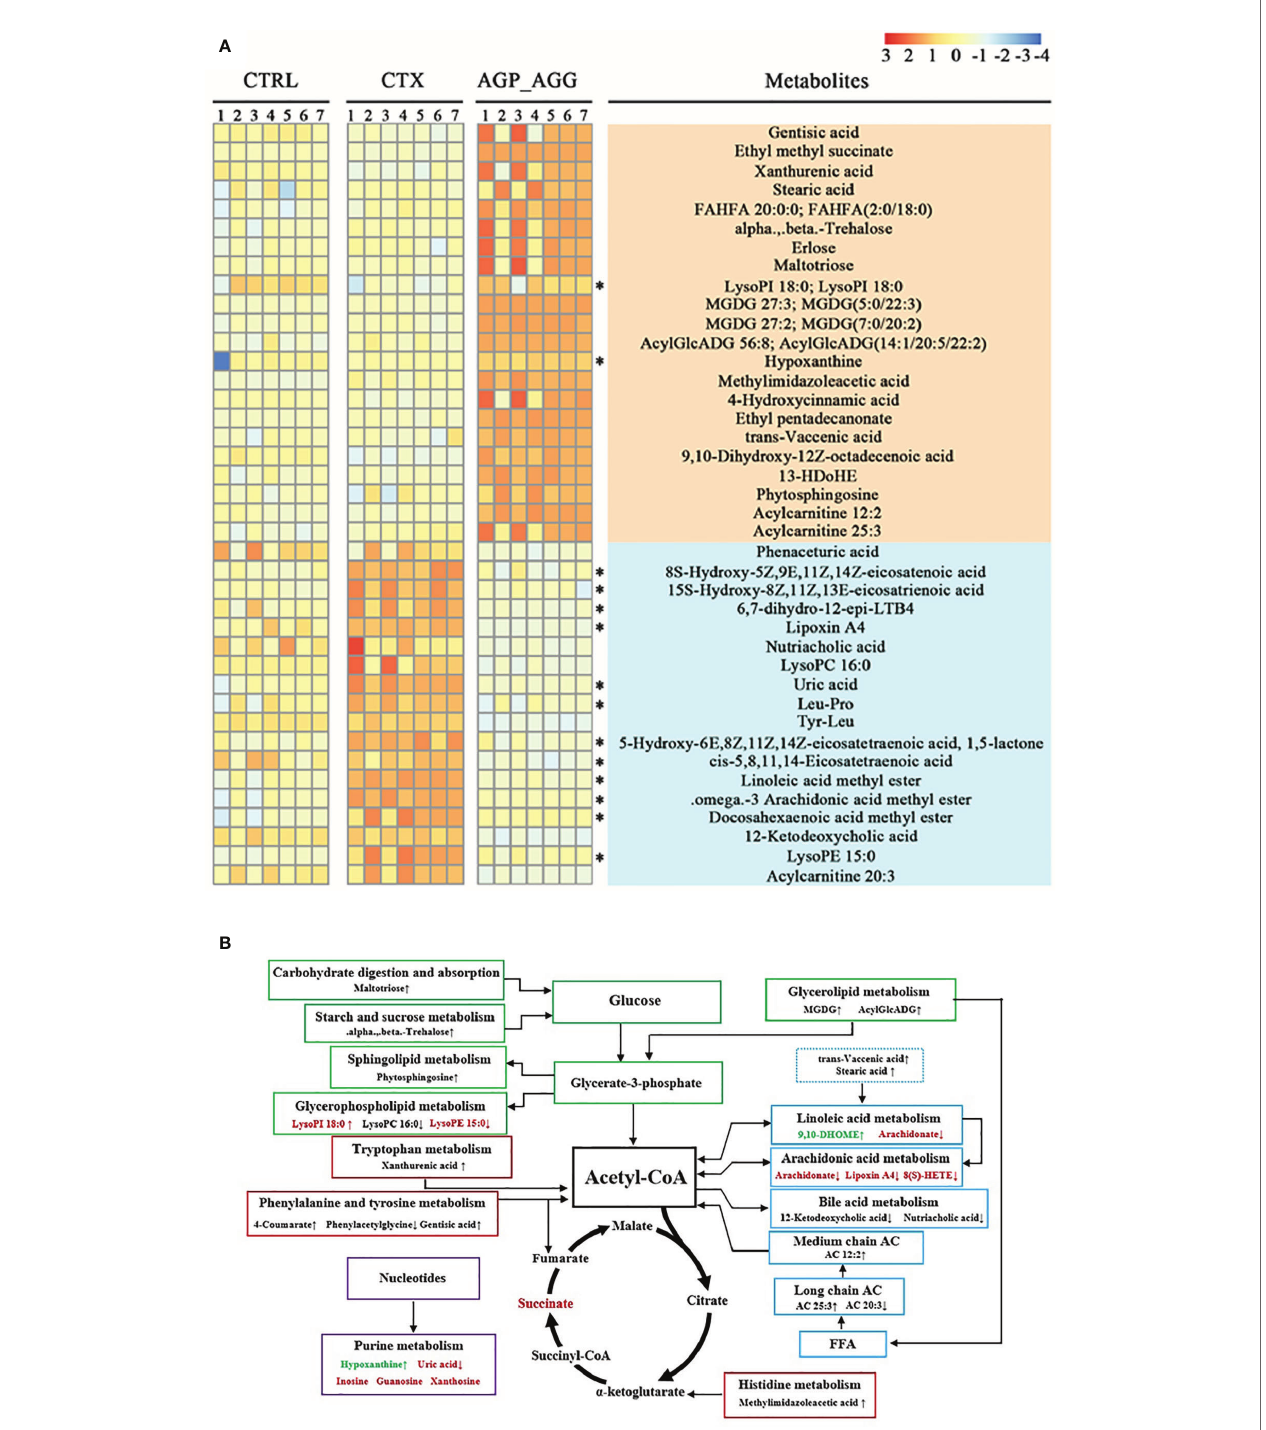
FIGURE 8 | Heatmap and metabolic network analysis of the identi fi ed metabolites. (A) Heatmaps of the differential metabolites that were altered by CTX compared with AGP_AGG mice. Asterisks represent metabolites whose abundance in CTRL mice was altered by CTX and then regulated by AGP_AGG. (B) The pro fi le of metabolic network analysis of the identi fi ed metabolites based on the known metabolic pathways. Red color represents signi fi cantly increased metabolites in CTX group, while green represents decreased dramatically, compared to CTRL group. “ ↑↓ ” describes metabolites that were signi fi cantly up- or down-regulated after AGP_AGG treatment. FFA, free fatty acid; AC, acylcarnitine; CTRL, control group; CTX, cyclophosphamide-induced immunosuppressive group; AGP_AGG, American ginseng polysaccharide+American ginseng ginsenoside with cyclophosphamide-induced immunosuppressive